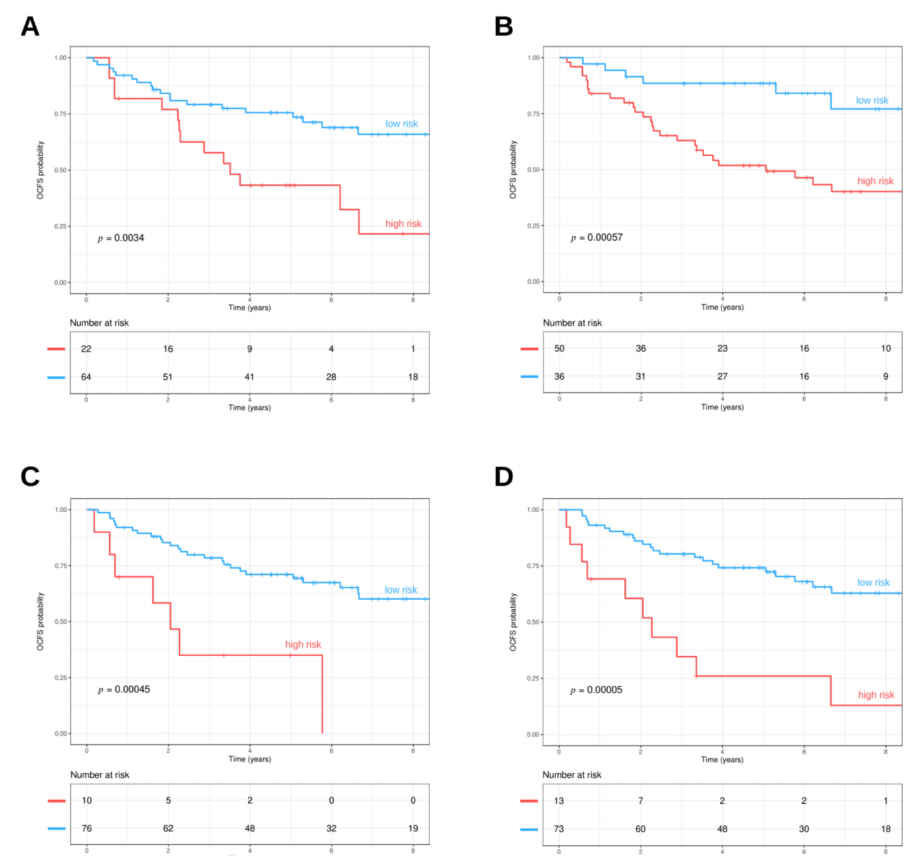
Figure 3. ( A ) 13-gene oral cancer signature. The prognostic model was applied to the OPL dataset and stratified patients in high (red line) and low (light blue line) risk groups ( p = 0.0034, log-rank test). ( B ) Signature related to genes related to lipid metabolism. The three gene signatures (TGFB1, SPP1, SERPINE1) identified by Hu et al. were applied to the OPL dataset. The signature visualized two di ff erent trends in patients, those with lower (light blue line) and higher risk (red line) ( p = 0.00057, log-rank test). ( C) MPRS. The metabolic pathway signature (MPRS) based on 6 gene sets was applied to the OPL dataset. The MPRS stratified patients with lower (light blue line) and higher risk (red line) ( p = 0.00045, log-rank test). ( D) Hypoxia signature. The hypoxia signatures based on 99 genes were applied to the OPL dataset. The hypoxia signature stratified patients with lower (light blue line) and higher risk (red line) ( p < 0.0001, log-rank test).